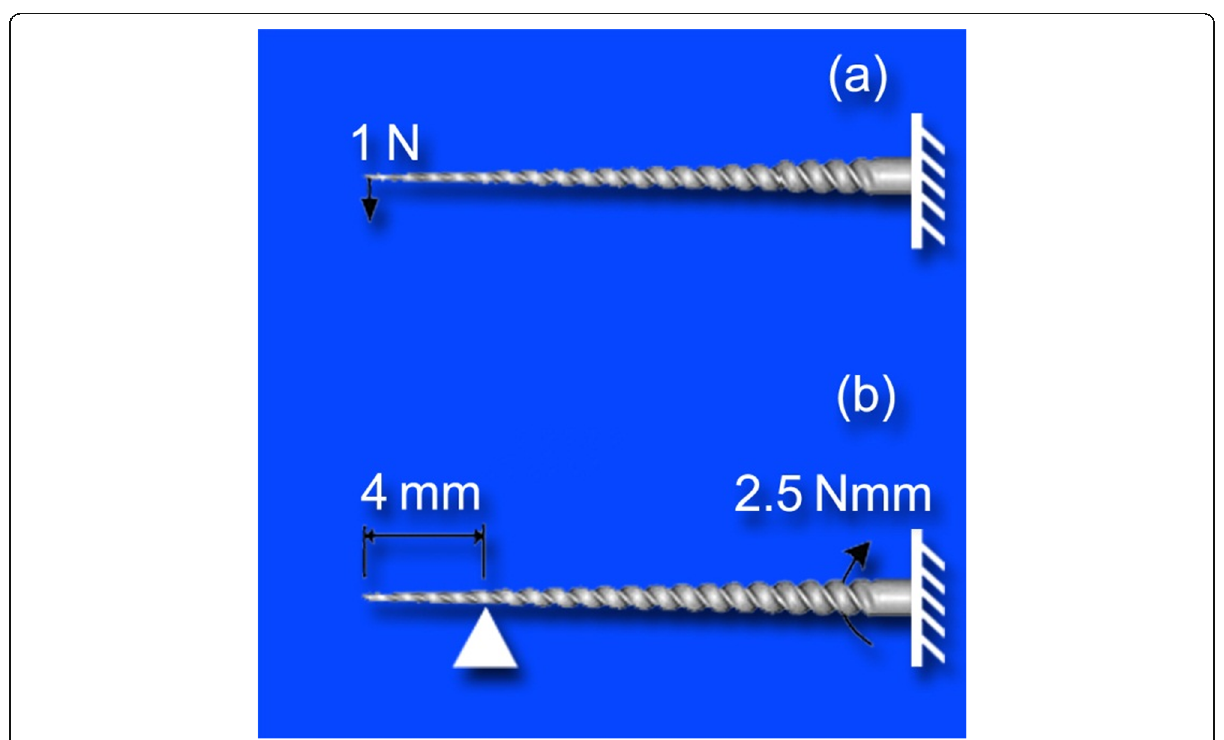
Fig. 1 Experimental simulated conditions diagram. a Cantilever bending with a concentrated load of 1 N applied to the instrument tip. b Shear moment of 2.5 N mm applied to the shaft with the instrument fixed rigidly at 4 mm from the